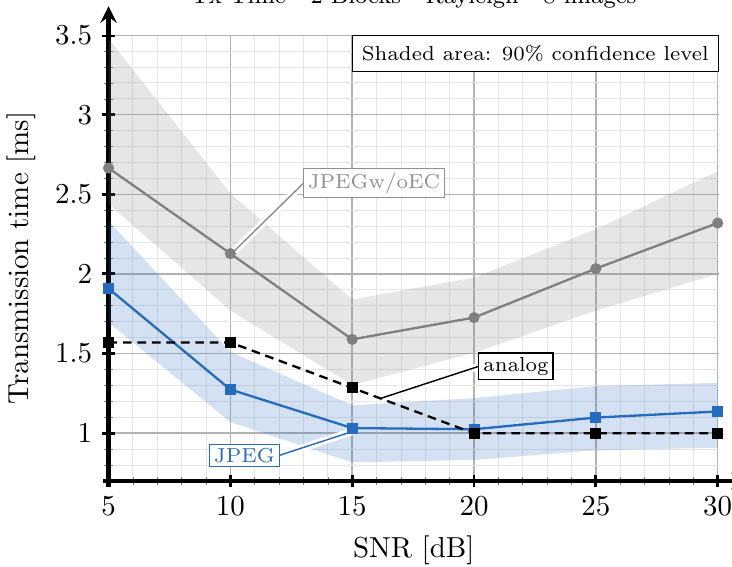
Figure 14. Average transmission time (considering 8 images) vs. SNR for two blocks and Rayleigh